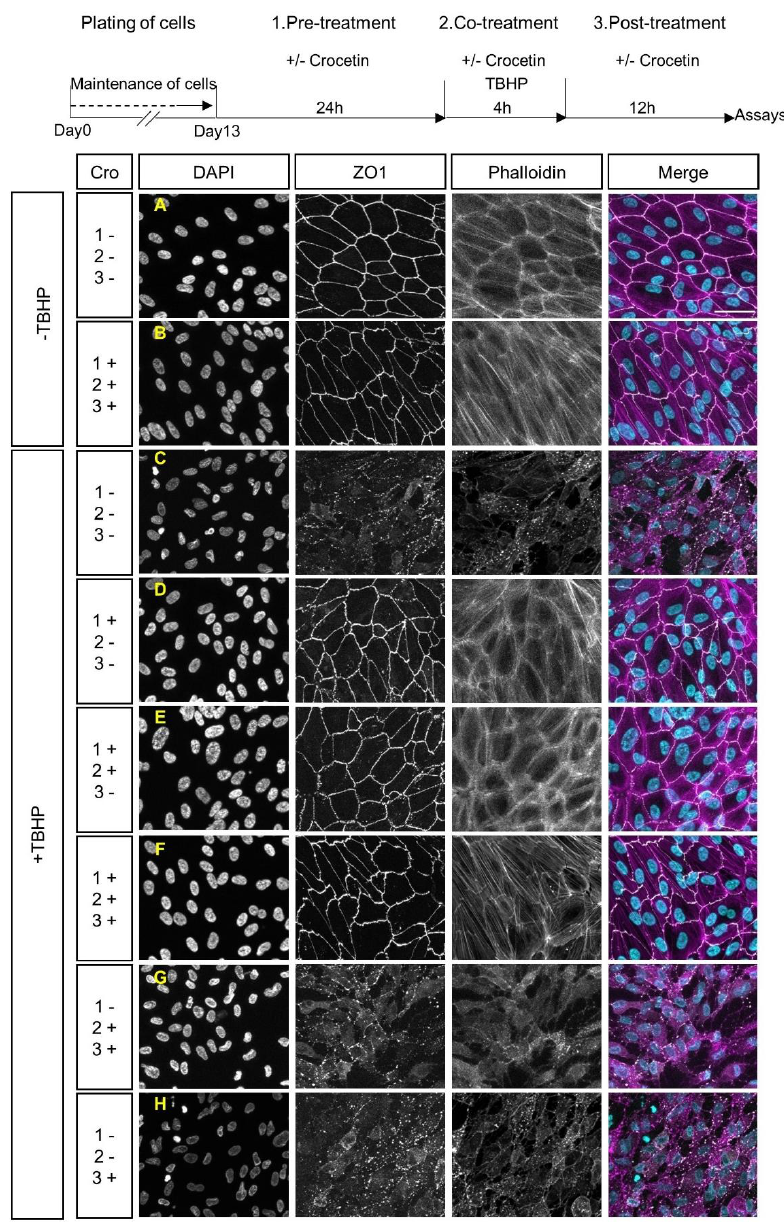
Figure 2. E ff ects of crocetin and TBHP on cellular morphology and junctional Figure 2. Effects of crocetin and TBHP on cellular morphology and junctional integrity. Schematic overview of crocetin treatment, which was applied at different time points. These were combinations of a 24 h pre-treatment with crocetin, 4 h co-treatment of crocetin with TBHP, and 12 h of post- treatment with crocetin in the media without TBHP. The ARPE19 cells were classified into five experimental groups based on various crocetin treatment protocols, which differed in timing of treatment with crocetin. These were combinations of pre-treatment (1.), co-treatment (2.), and post- treatment (3.) times. All of them were common in exposure to TBHP for 4 h. Images display the nuclear morphology (DAPI), cell-junction membrane marker (ZO1), F-actin distribution (Phalloidin),